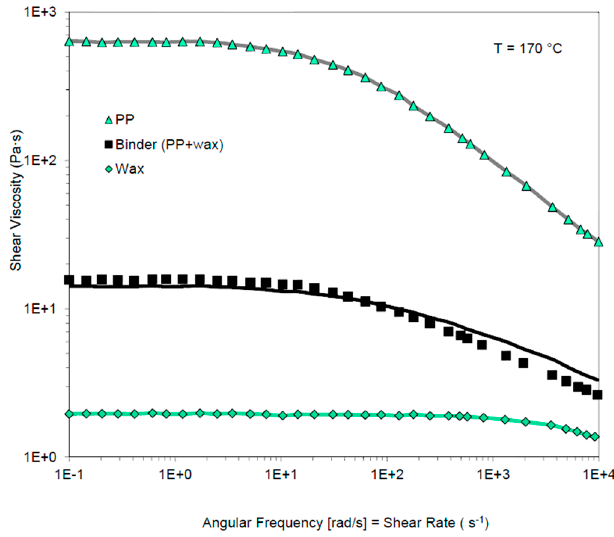
Figure 1. Viscosity of PP-based binder and its components at 170 ˝ C [41]. Components were fitted (line) by the Carreau model and binder with the Grunberg-Nissan model. © Christian Kukla (Montanuniversitaet Leoben). Figure first published by EPMA in the Euro PM2014